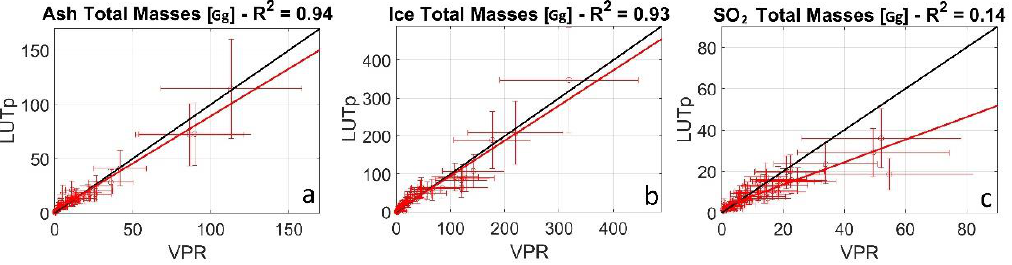
Figure 12. Comparison between SEVIRI ( a ) ash, ( b ) ice, and ( c ) SO 2 total masses computed using VPR and LUT p approaches.